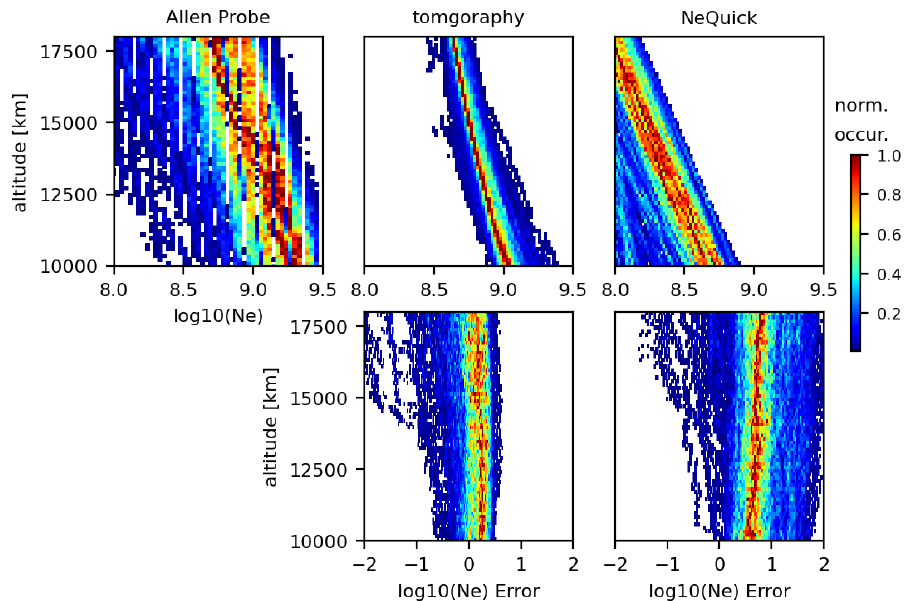
Figure 12. 2D histogram of profiles from the Van Allen Probes RBSP-A instrument ( top left ), tomog- raphy ( top middle ) and NeQuick ( top right ) as a function of the altitude and logarithm of electron density with base 10. The bottom panels show the corresponding errors of the profiles. The color of the points represents the normalized occurrence.